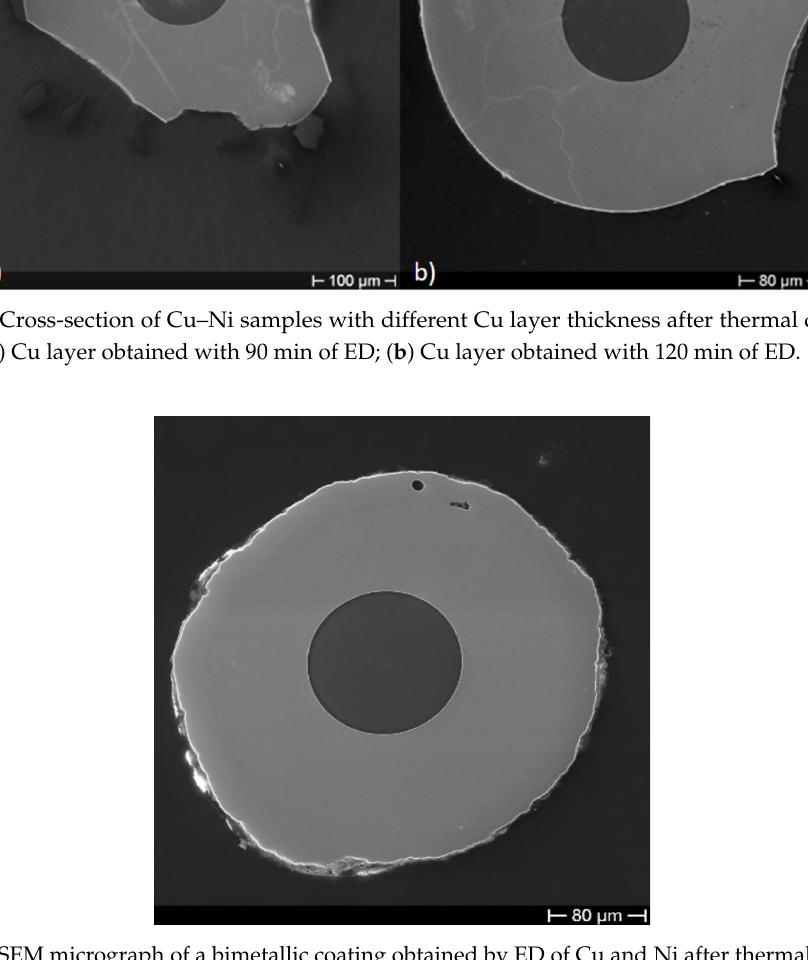
Figure 4. SEM micrograph of a bimetallic coating obtained by ED of Cu and Ni after thermal recovery